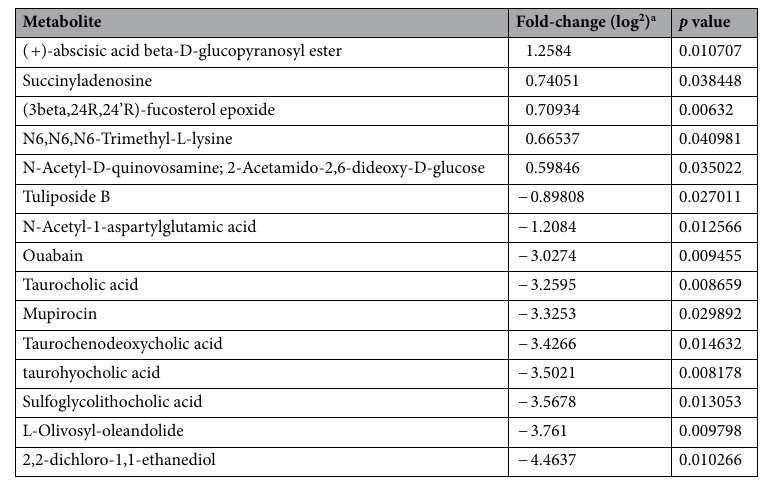
Table 4. List of metabolites in ETRF against TRF. a Fold change values described are the ratio of ETRF/TRF. The values are arranged from highest ratio (up-regulated) to the lowest (down-regulated).